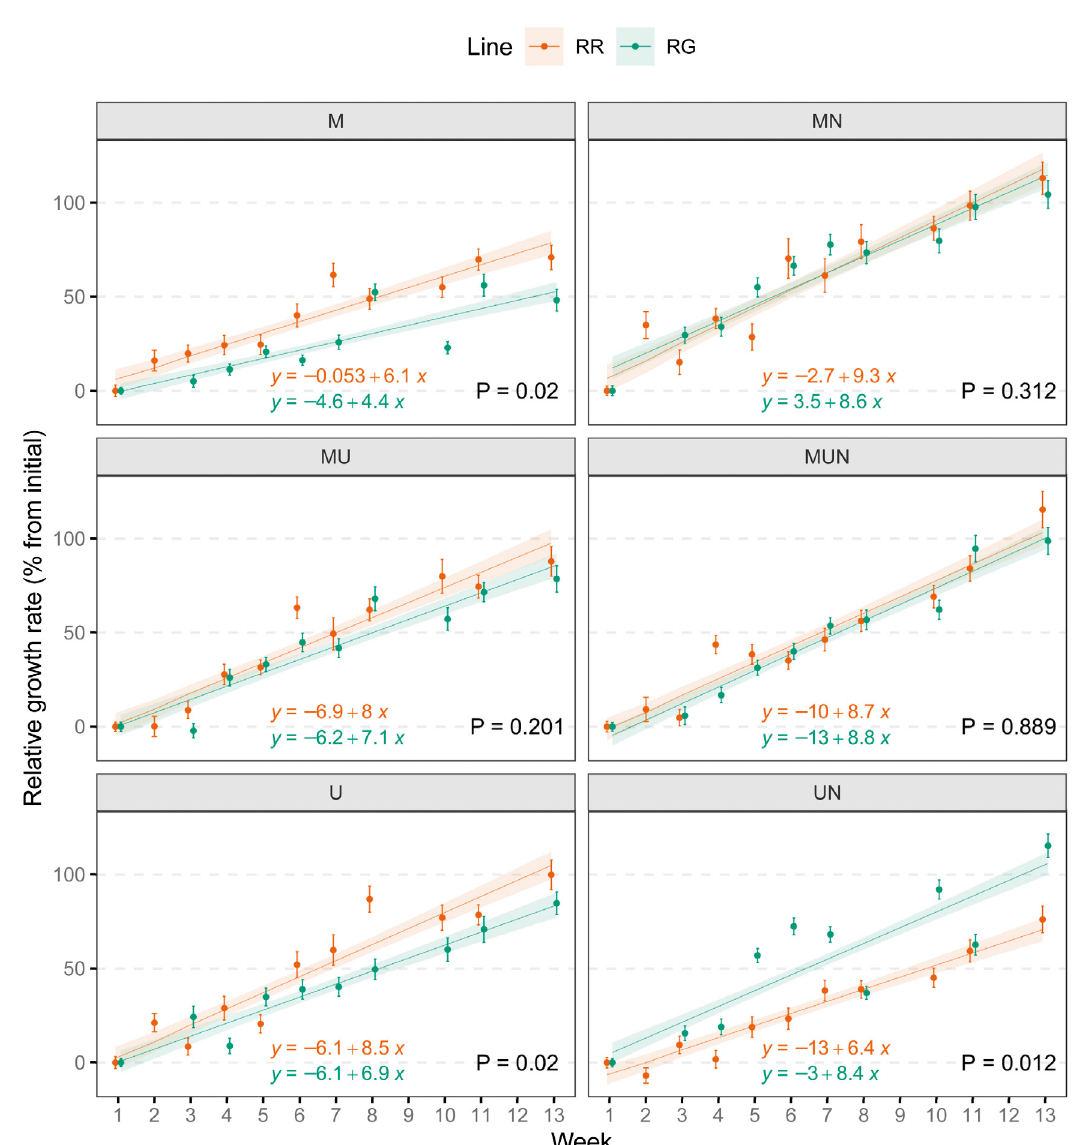
Fig. 1. – Relative growth rate increase in shell length (SL) of RR (red abalone, red line) and RG (hybrid abalone, green line) abalone in each diet treatment at the outset of the experiment. The points and error bars indicate mean ±SEM. Solid lines and shaded area indicate modelled values ±95% CI with the linear model formulae indicated for each abalone cross. For each diet, statistical differences in the slopes are indicated. M, Macrocystis pyrifera ; U, Ulva ohnoi ; MU, M. pyrifera and U. ohnoi ; MN, M. pyrifera and N. incerta ; UN, U. ohnoi and N. incerta ; MUN, M. pyrifera , U. ohnoi and N. incerta